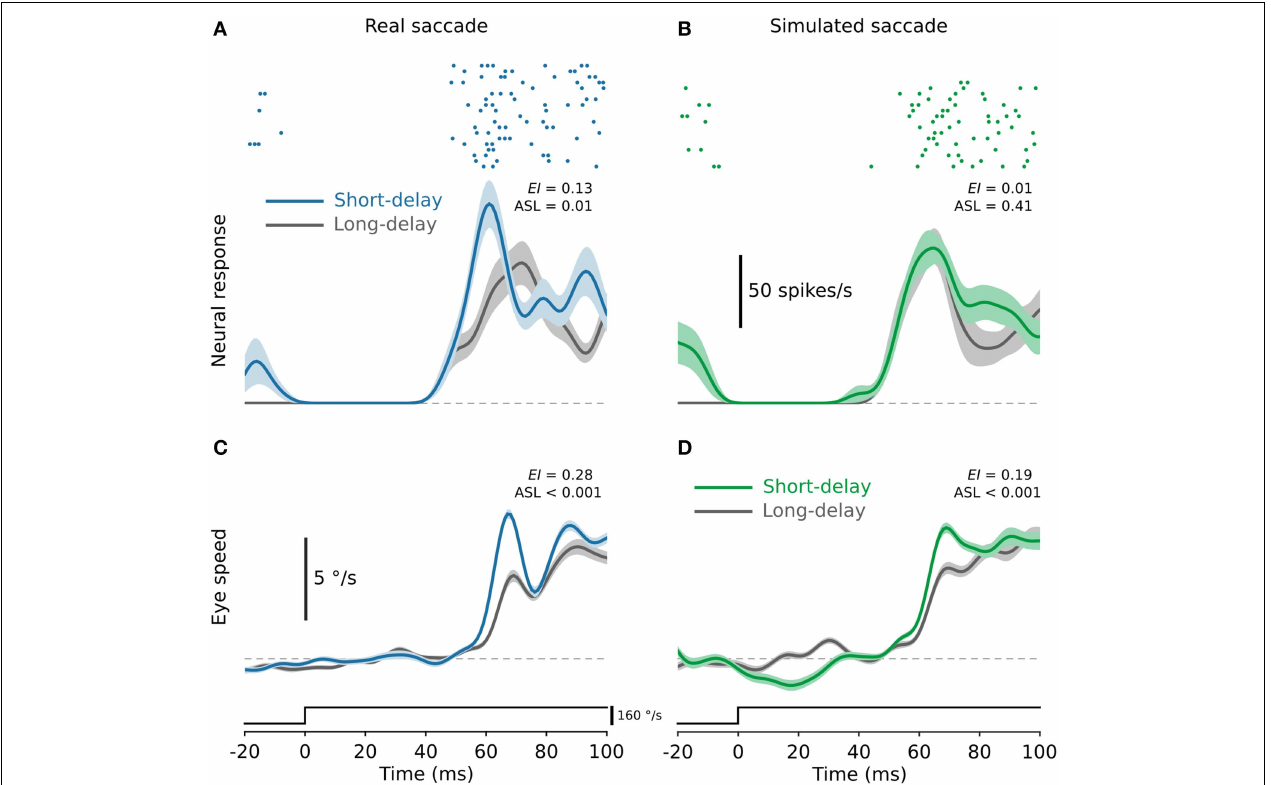
FIGURE 2 | Post-saccadic enhancement of neural responses and ocular following eye speed. (A) Representative neural responses from a single MSTd neuron for test stimuli delivered after real saccades. Responses for the short-delay condition (blue) are significantly enhanced compared to those for the long-delay condition (gray). (B) Responses from the same neuron for the same test stimulus delivered after simulated saccades. There is no evidence of enhancement of neural responses after simulated saccades. In both (A,B) the raster plots show responses for the short-delay condition. (C,D) Representative ocular following eye speeds for the same test speed for which the recordings in (A,B) were obtained. Ocular following eye speed is significantly enhanced in the short-delay condition compared to the long-delay condition following both real (C) and simulated (D) saccades. In all panels, solid lines show the average across all trials of a given condition and the shaded regions indicate ± 1 SE, estimated by